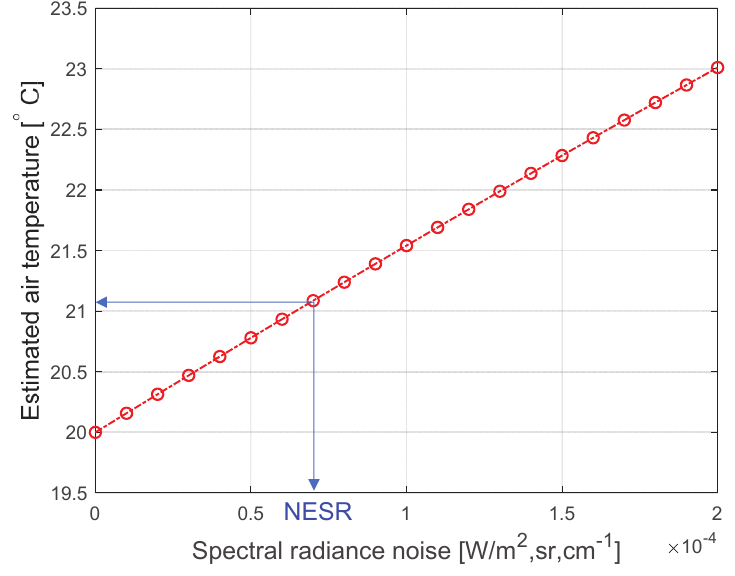
Figure 20. Spectral noise and estimated air temperature